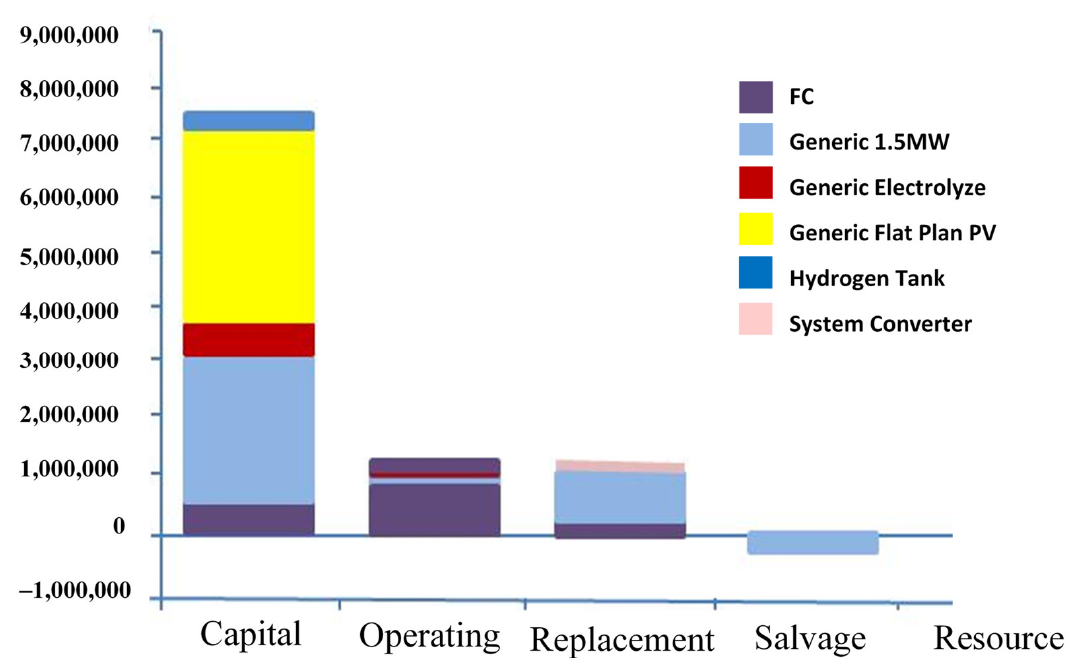
Figure 20. Summary of total costs of the PV/FC/Wind hybrid suggested system.